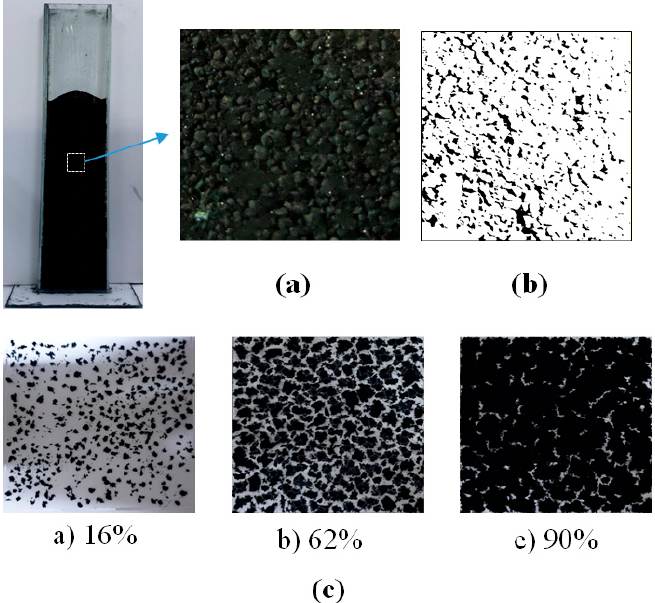
Figure 9. ( a ) Surface photograph of ENCNT-I in loosely packed bed; ( b ) processed image of Figure ( a ); ( c ) two- dimensionally simulated photographs for given solid holdups.